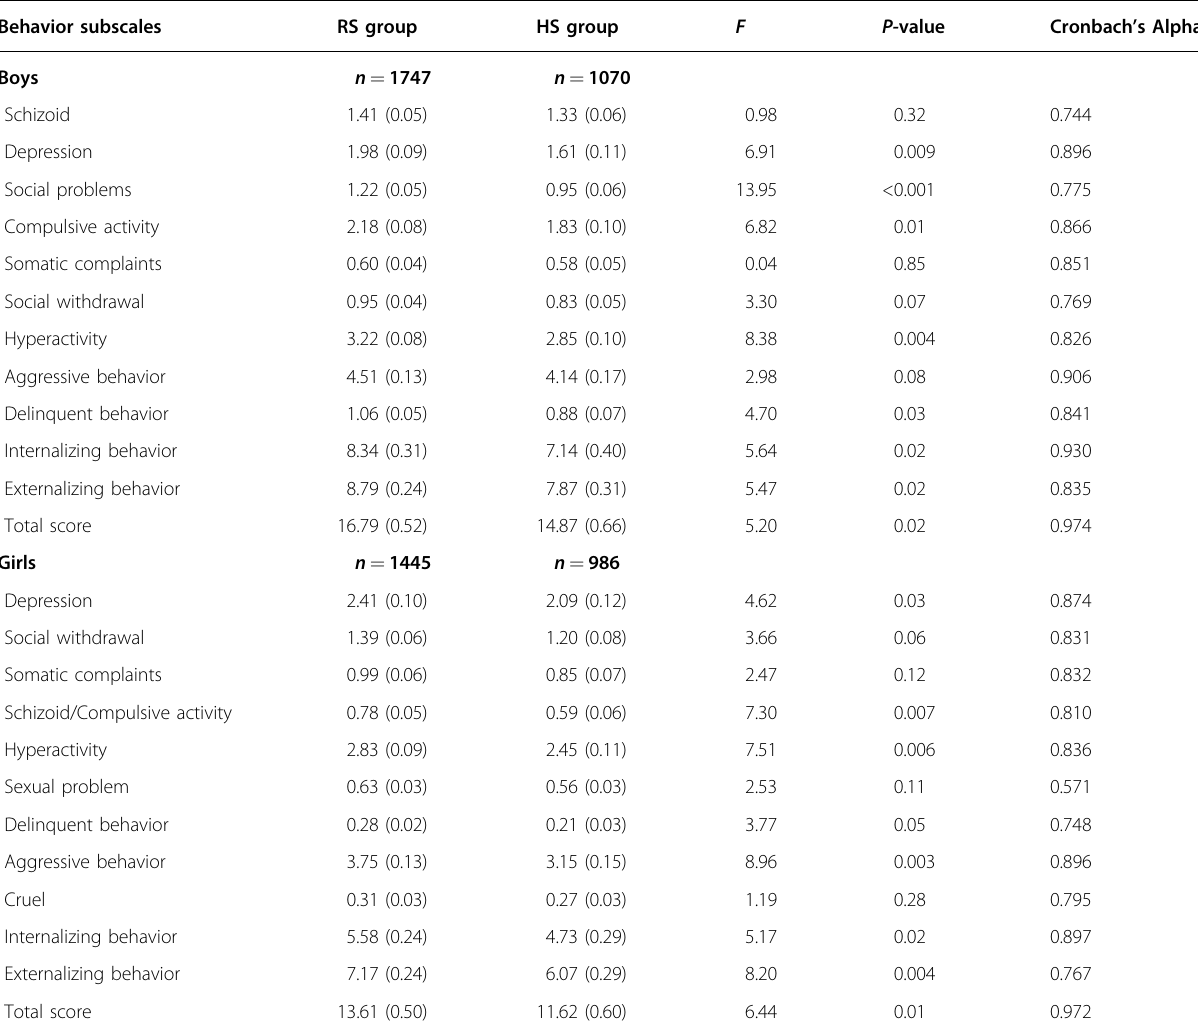
Table 2 Comparison of CBCL scores between RS group and HS group (boys and girls of 6 – 11 years) during COVID-19. Behavior